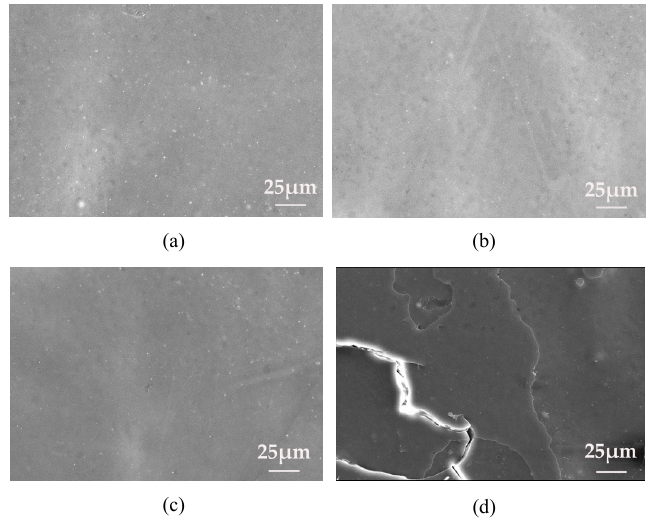
Figure 6. Microscopic morphology of different samples. ( a ) Non-irradiated, ( b ) 10 5 rad (Si), ( c ) 2.5 × 10 7 rad (Si), ( d ) 5 × 10 7 rad (Si).